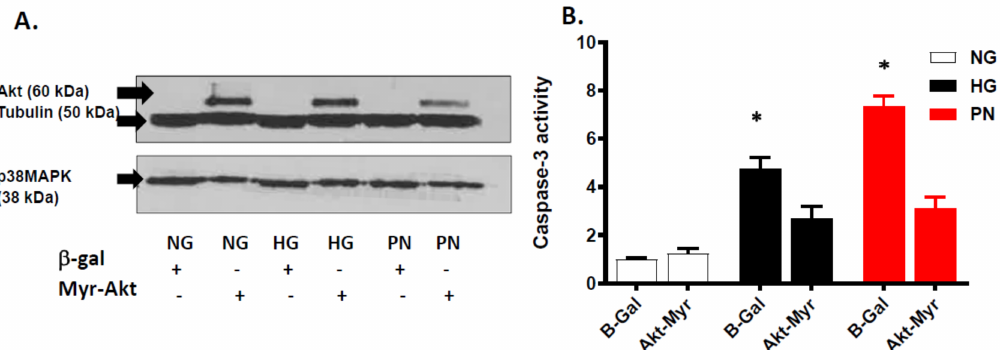
Figure 6. Overexpression of Myr-Akt attenuates proapoptotic effect of high glucose and peroxynitrite. ( A ) Representative Western blot showing selective expression of Akt in retinal EC cultures transfected with constitutively active Akt (Myr-Akt), but not in cultures transfected with adenovirus construct of β -galactosidase ( β